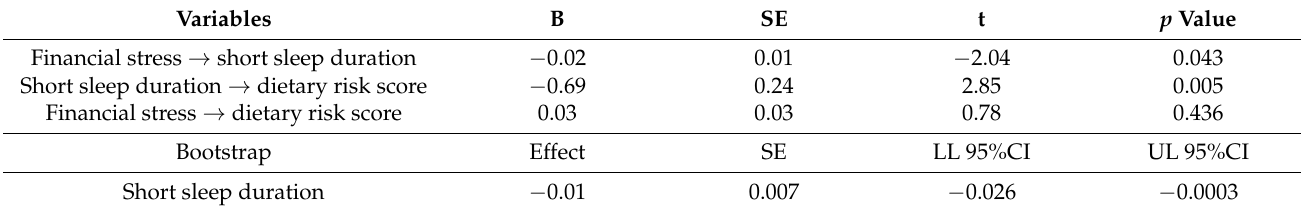
Table 8. Model 2 Mediation Analysis of Students Not Meeting the Minimum Sleep Duration.